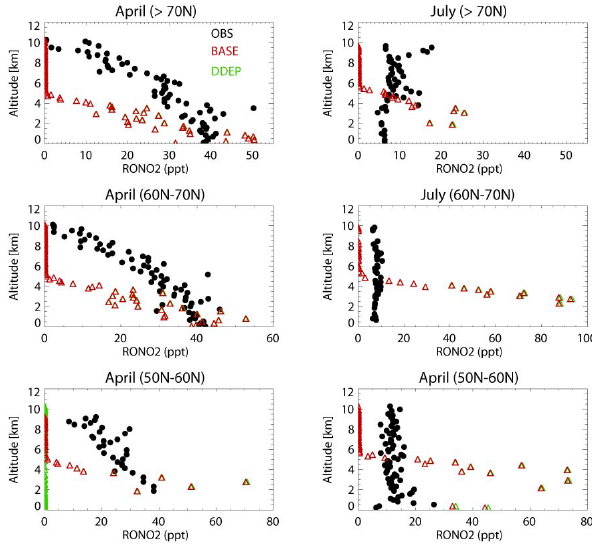
Fig. 10. A comparison of the distribution of higher alkyl nitrates as measured during April and July 2008 during the ARCTAS measure- ment campaign and simulated by TM5. The simulations shown are for BASE (blue) and EMISS (orange).The reader should note the different scales on the x axis between latitudinal